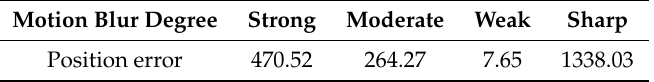
Figure 11. Result of future frame prediction for a video sequence with the same object states but different shutter speeds. GT is the ground-truth, Pred is the model’s prediction, and Diff is the difference between Gt and Pred. The green area represents the correct part, and the red area represents the wrong part of the model’s prediction. Table 4. Position error according to the degree of motion blur.